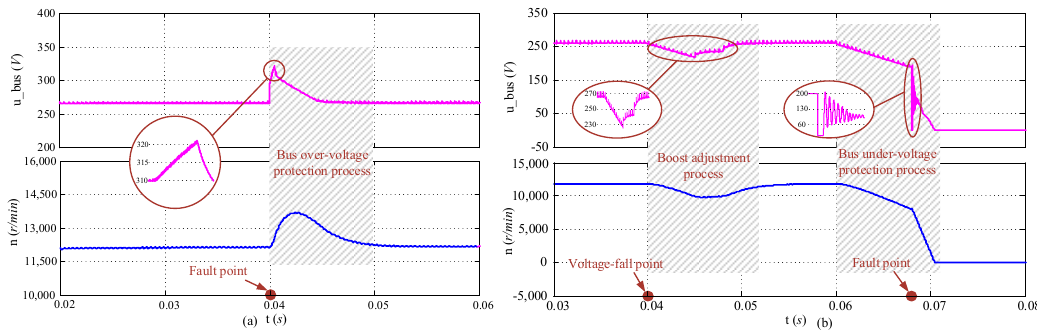
Figure 14. Waveforms of bus-voltage and motor speed during the bus-voltage fault protection process; ( a ) over-voltage protection; ( b ) under-voltage protection.